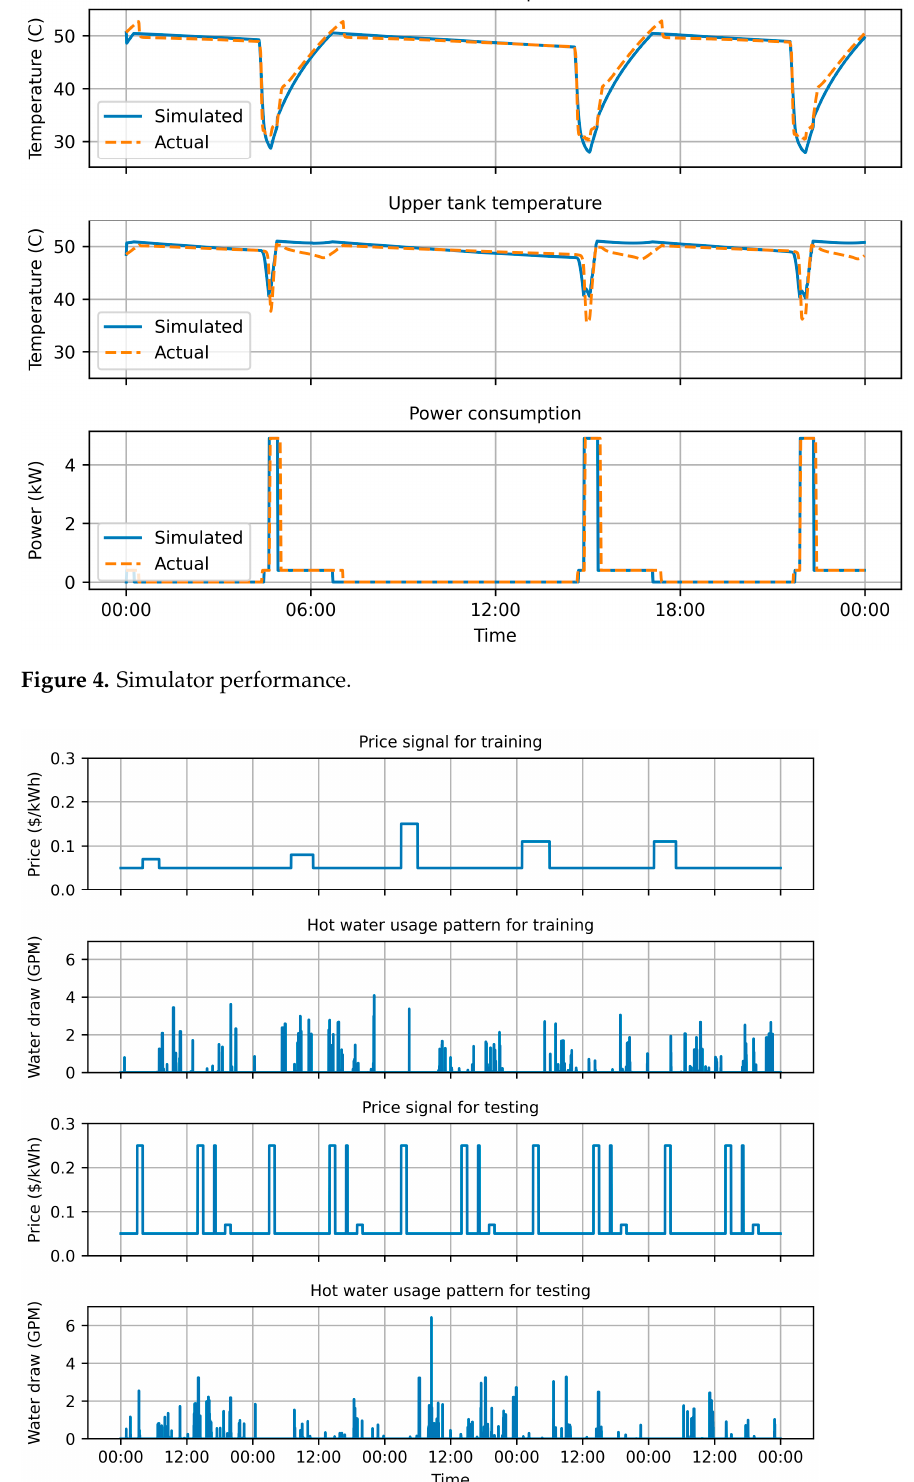
Figure 5. A sample from price and hot water profiles for training and testing.